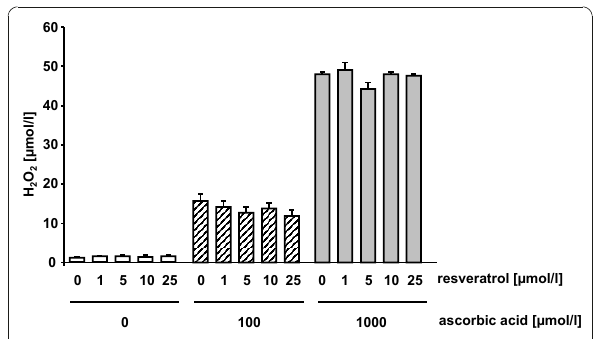
Figure 6 Production of hydrogen peroxide by resveratrol and ascorbic acid . Production of hydrogen peroxide in DMEM medium supplemented with resveratrol in the absence and presence of ascorbic acid. Data are mean ± SEM of at least 2 experiments performed in